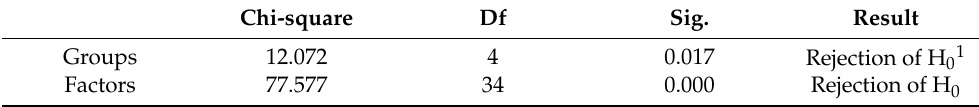
Table 5. Results of Friedman test (Significance of groups and factors affecting human errors in UCI). Chi-square Df Sig.